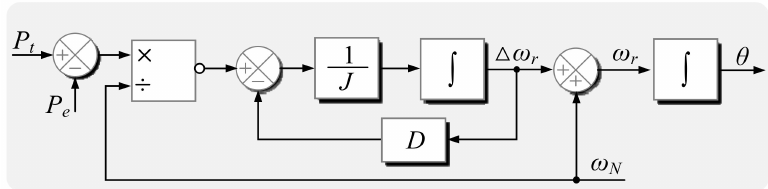
Figure 4. Block diagram of the virtual rotating function part.